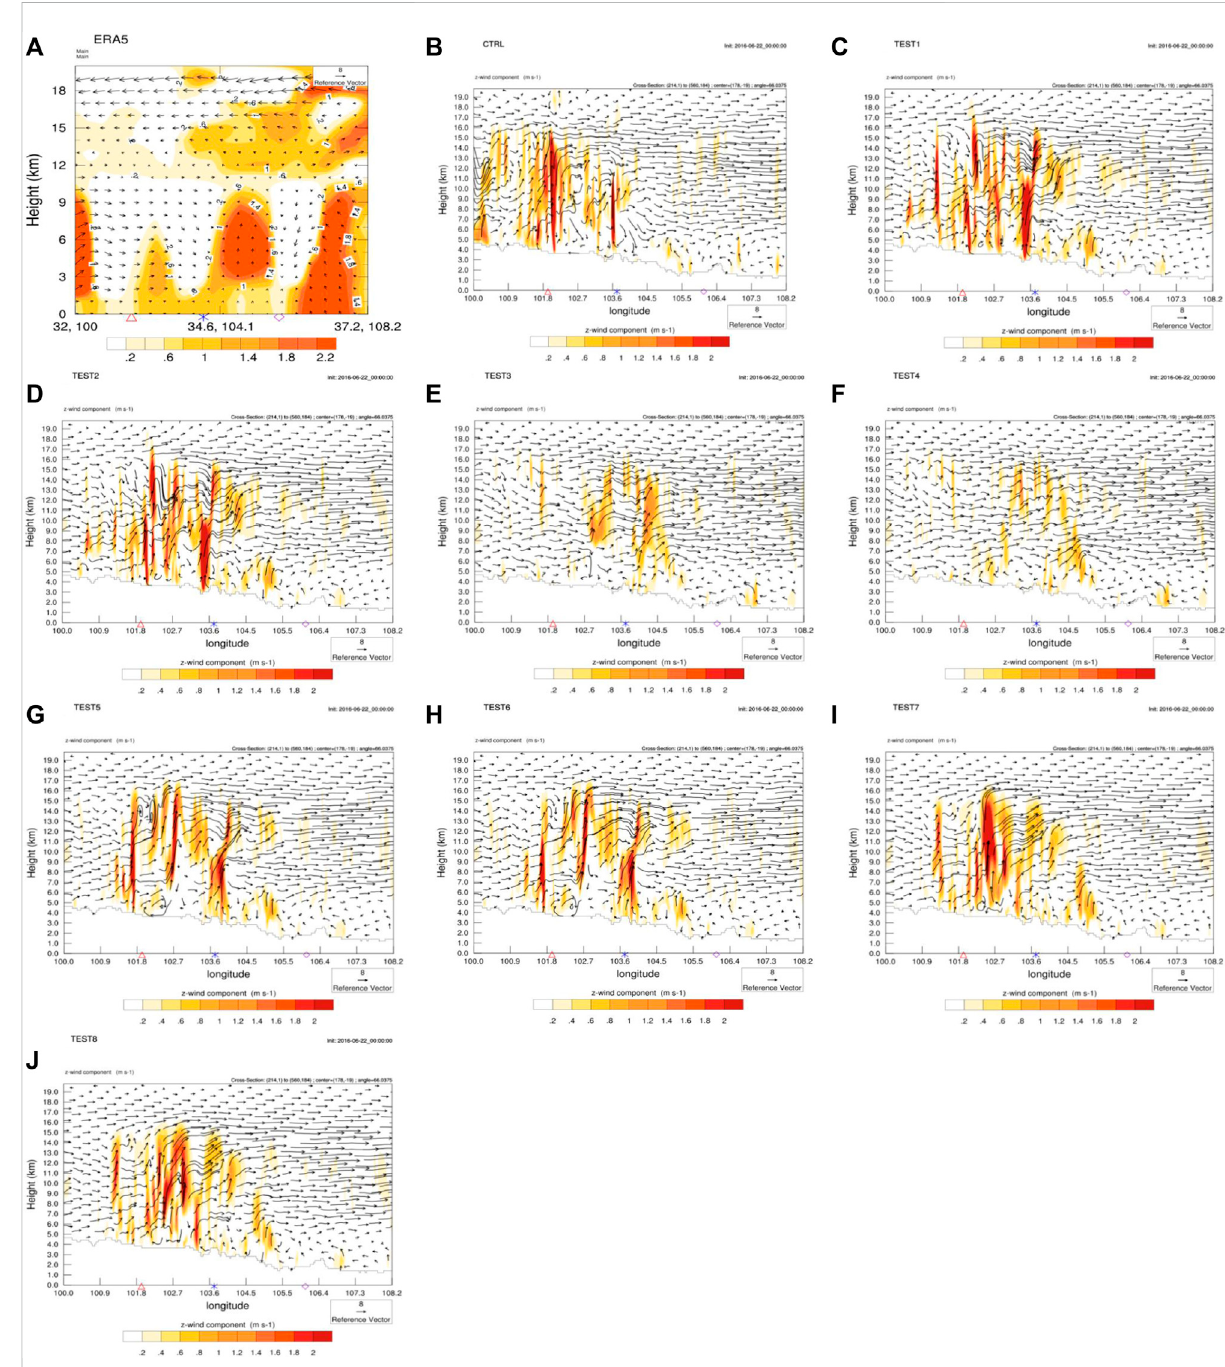
FIGURE 4 Verticalsectionofverticalvelocity(shaded,unit:m/s)andverticalwind fi eld(arrow,unit:m/s)overAreaA,Chinaat19:00on22June2016(unit: K) (A) ERA5; (B) CTRL (C-J) TESTs 1 –